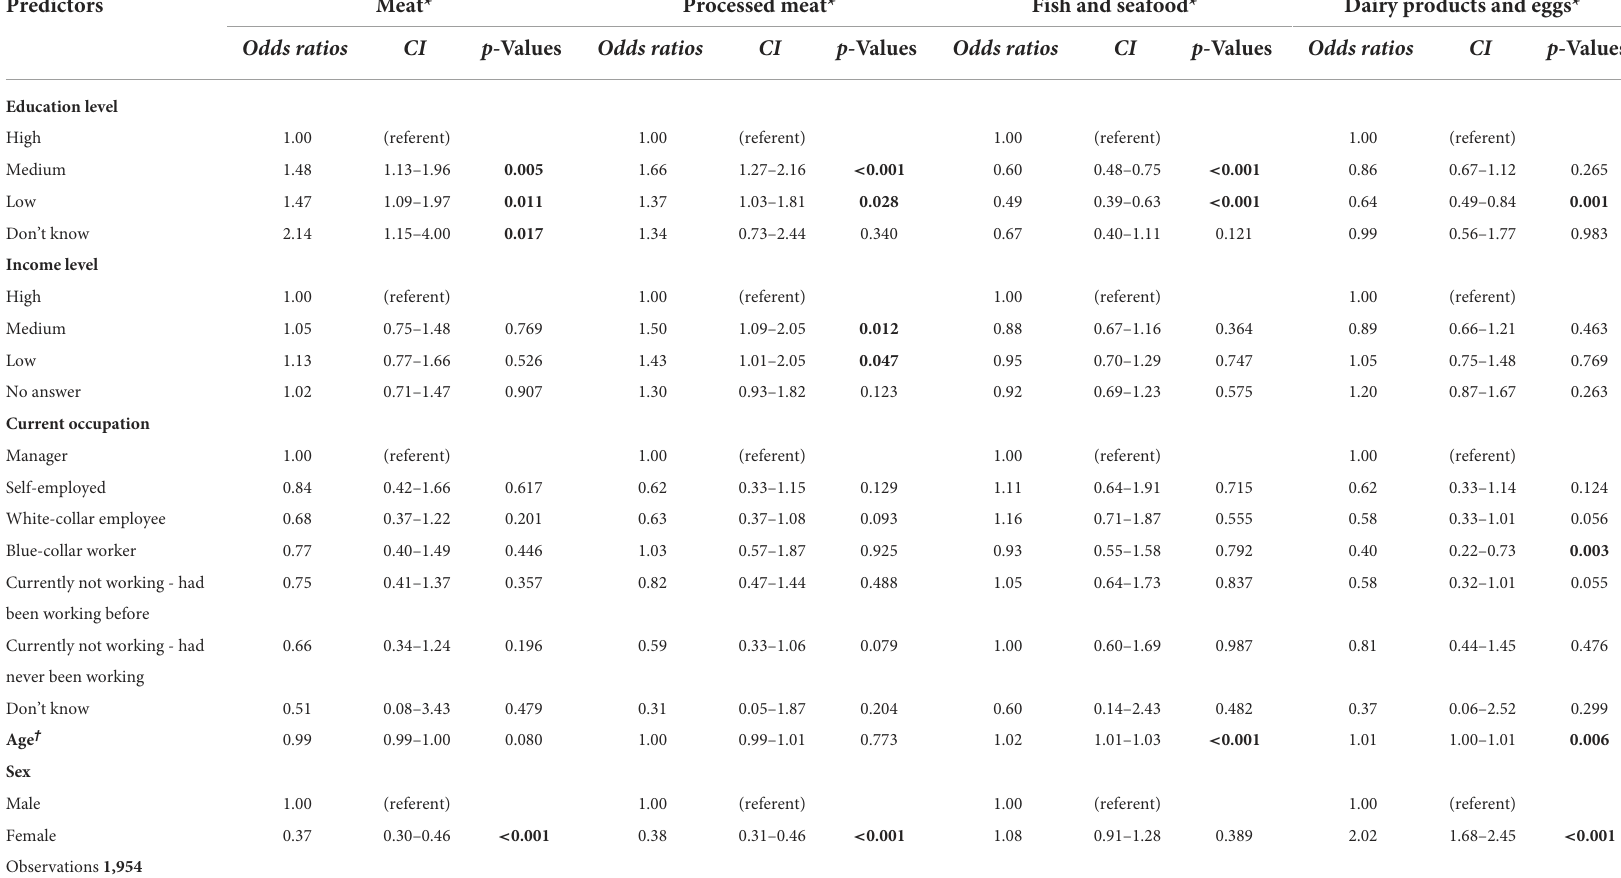
TABLE 3 Odds ratios, 95% confidence intervals and p -values for frequency of consumption of animal products 2011.